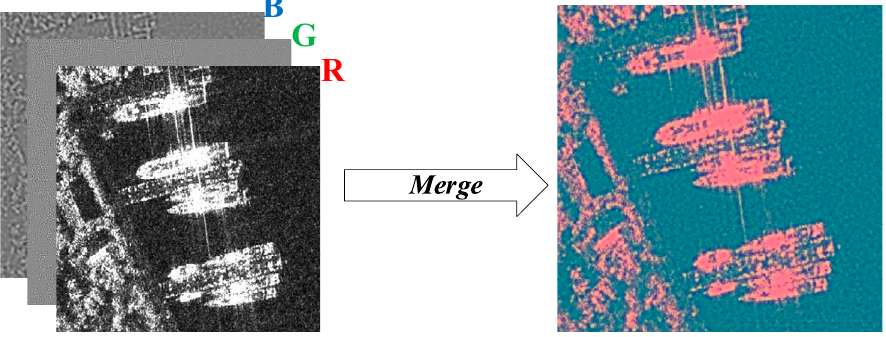
Figure 5. Merge to Three-channel images.